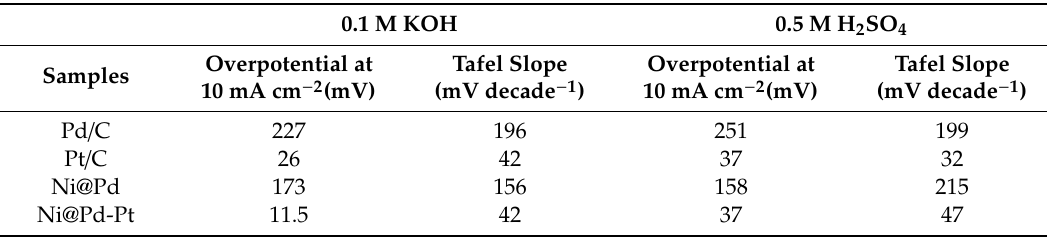
Figure 4. ( a ) The linear sweep voltammetry (LSV) and related ( b ) Tafel plots of experimental NCs under investigation in alkaline medium (0.1 M KOH). ( c ) LSV curves and related ( d ) Tafel plots of experimental NCs under investigation in acidic medium (0.5 M H 2 SO 4 ). All the LSV curves were measured in 0.1 M KOH electrolyte solution at a scan rate of 2 mV s − 1 . Table 2. The hydrogen evolution reaction (HER) parameters of experimental NCs under investigation in alkaline and acidic medium.